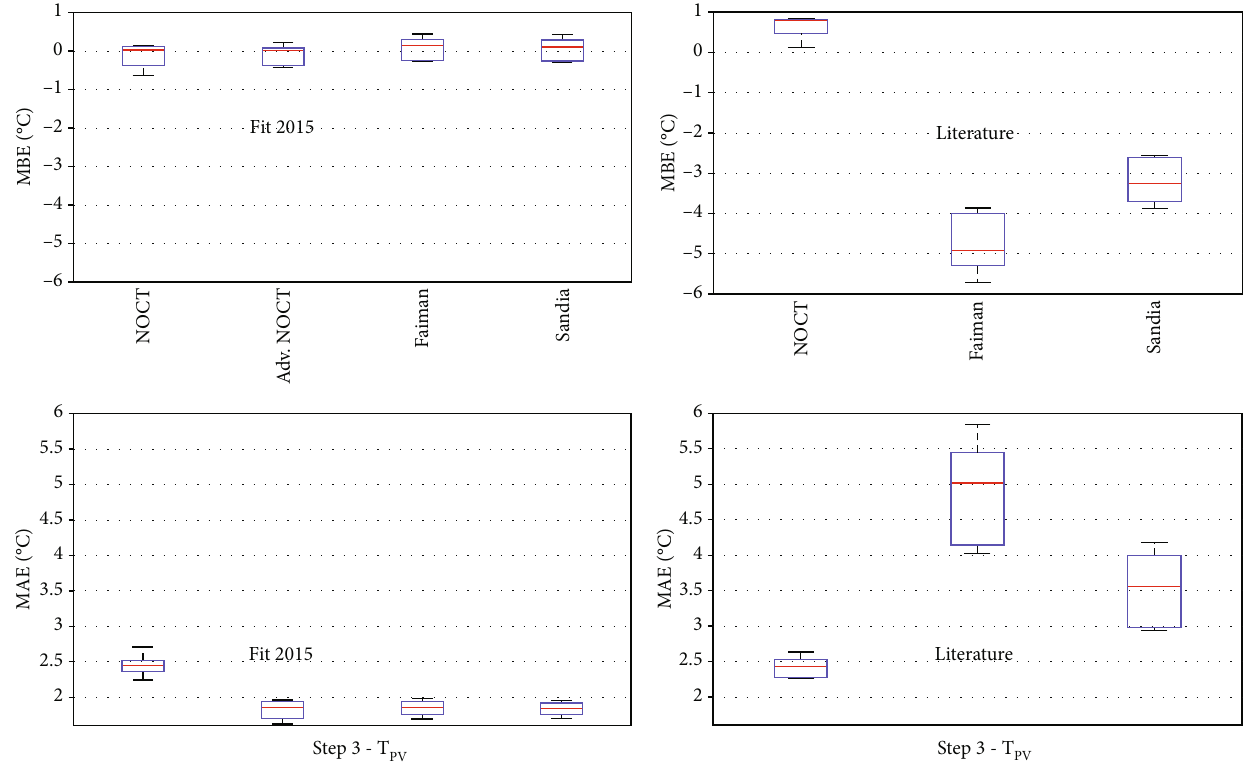
T fi tted coe ffi cients (left) and PV from GHI, amb , and WS,